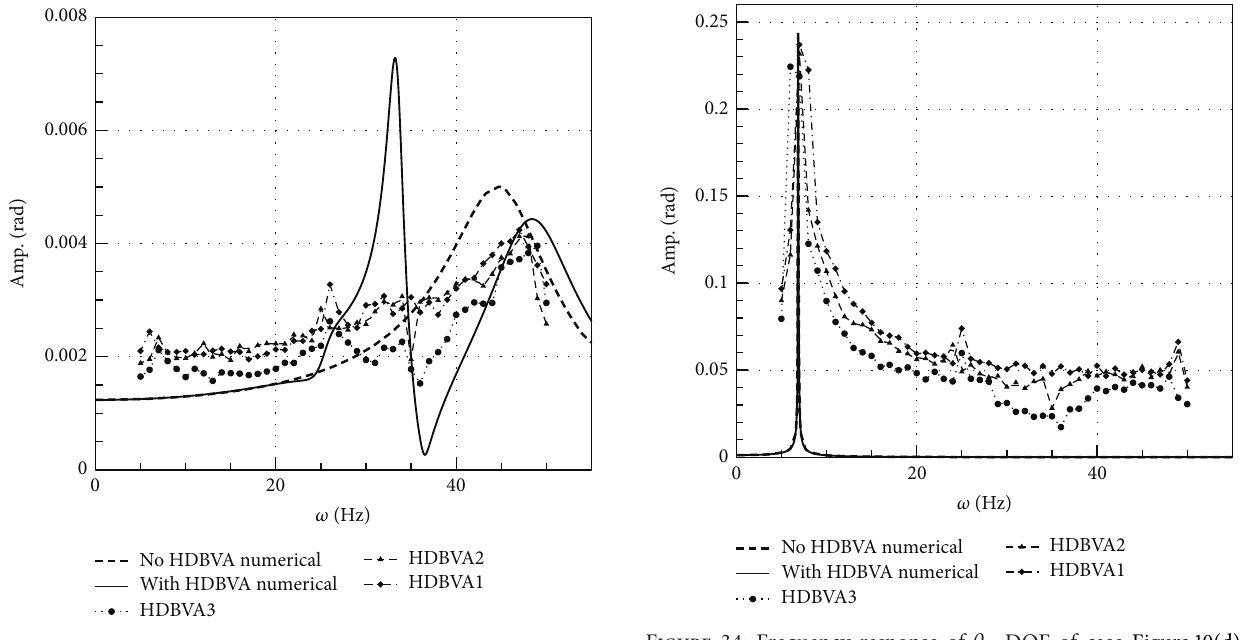
Figure 32: Frequency response of 𝜃 𝑋 DOF of case Figure 10(d), HDBVAs start at the far-from-force point.